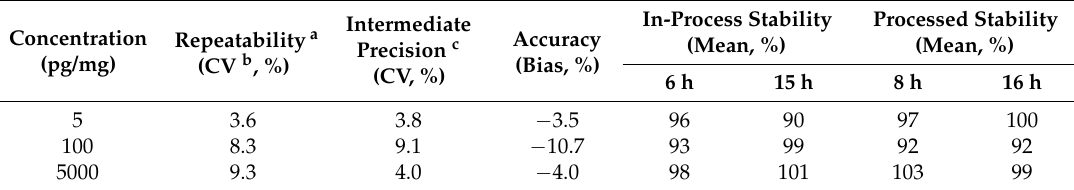
Table 2. Summary of validation data.